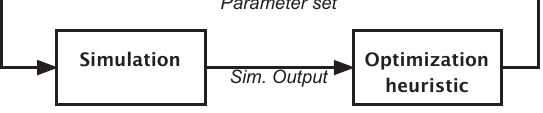
Figure 1: Common black-box optimization, see